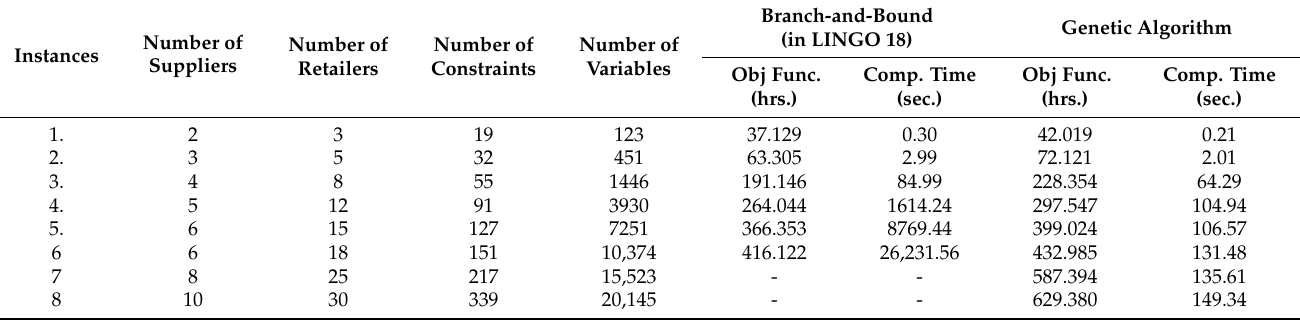
Table 5. Computational experiments of eight